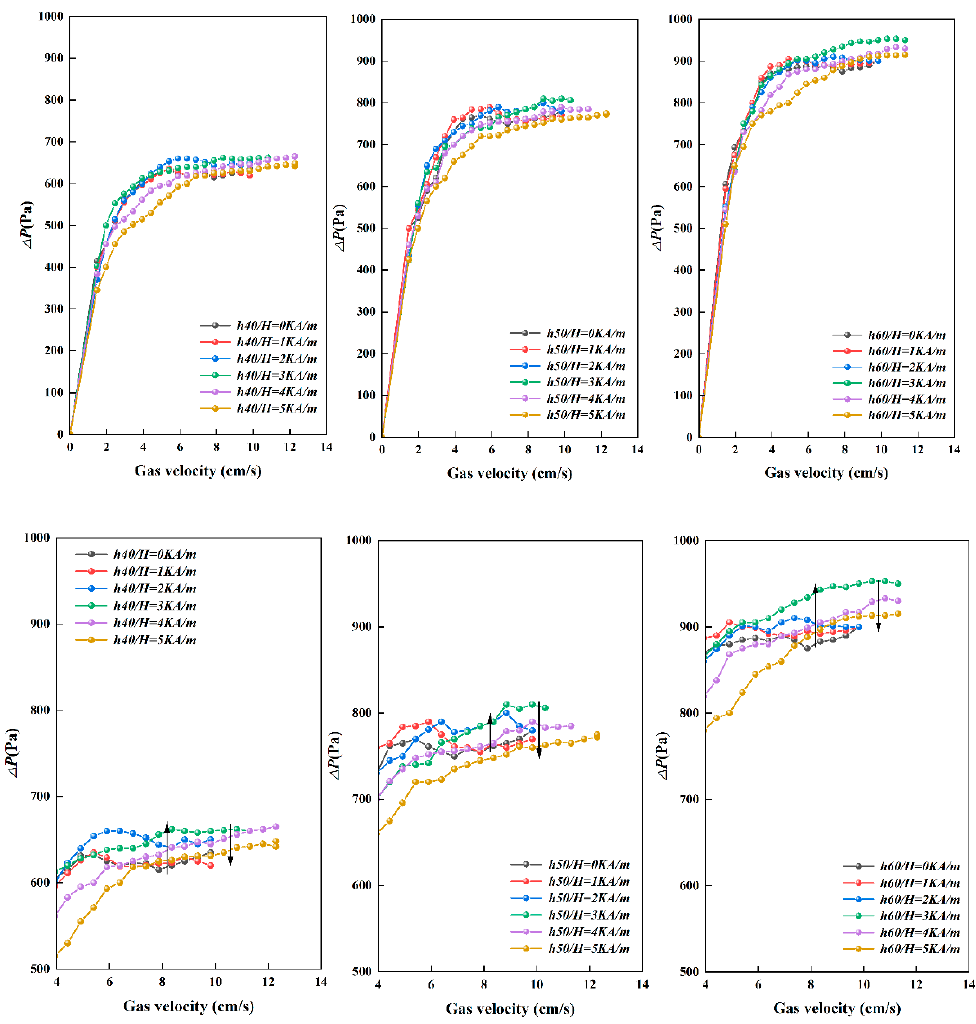
Figure 3. Fluidization characteristics curves of microfine particles as magnetic field strength changes.